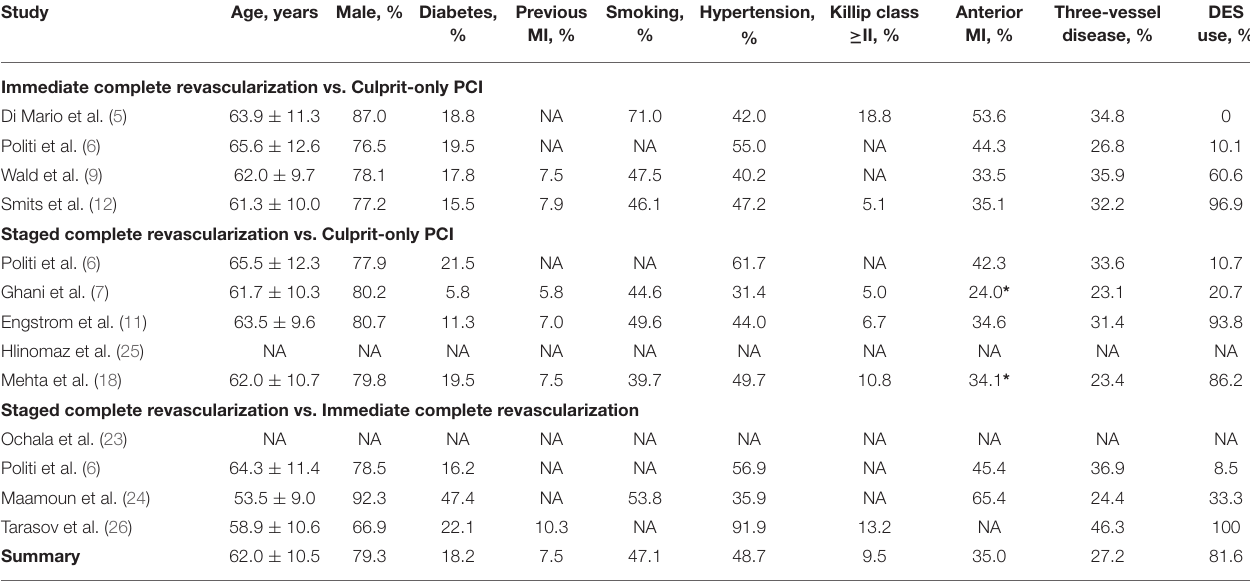
TABLE 2 | Baseline characteristics of the patients.